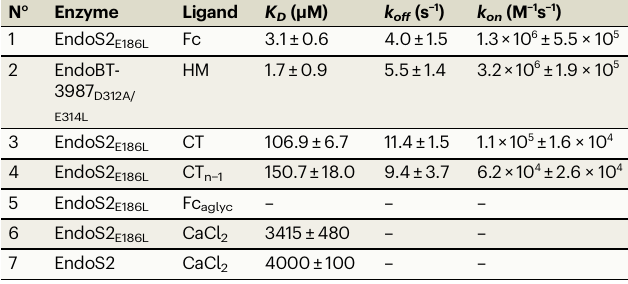
Dissociationconstants K D ,on-andoff-rateconstants k on and k off forRituximab-Fc,CT,CT n-1 HM andCa 2+ binding to EndoS2 E186L , EndoS2 andEndoBT-3987 D312A/E314L from fi tting a two-state binding modeltomethyl-TROSYtitration data using